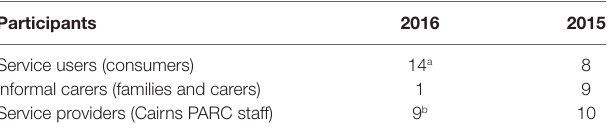
taBlE 1 | Cairns Prevention And Recovery Care (PARC) evaluation participants in 2015 and